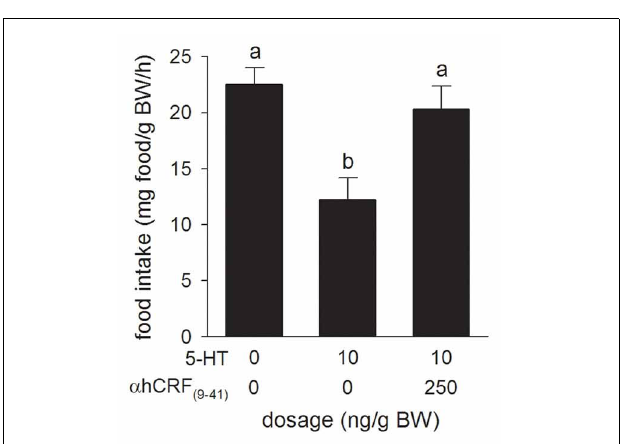
FIGURE 4 | Effects of i.c.v. injections of modified teleost Ringer’s (30% methanol, 70%, teleost Ringer’s), rainbow trout CRF (rtCRF) or rtUI alone, or in combination with the mixed 5-HT 1 /5-HT 2 receptor antagonist, methysergide on food intake in rainbow trout. Assessment of food intake was carried out as in Figure 1 . Bars that do not share a common letter are significantly different from each other as determined by a One-Way ANOVA and by a pairwise Tukey’s test ( P < 0 . 05). Values are means + sem ( n = 8).